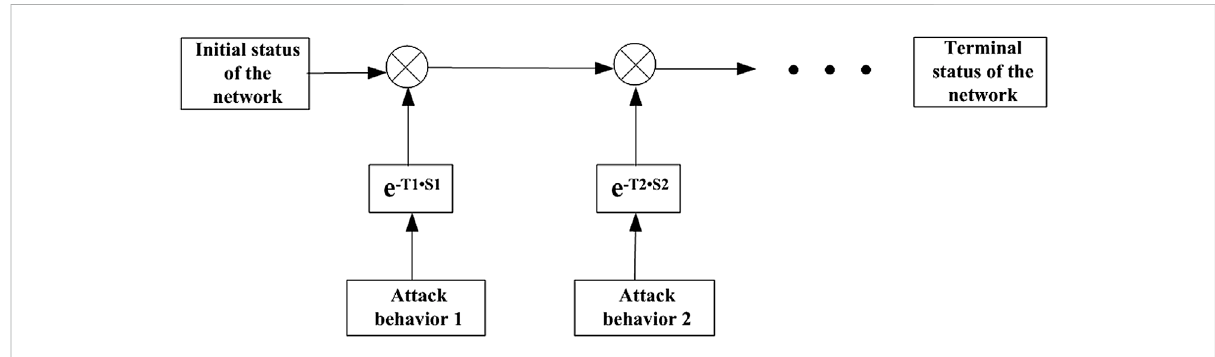
FIGURE 3 The diagram of cyber-attack